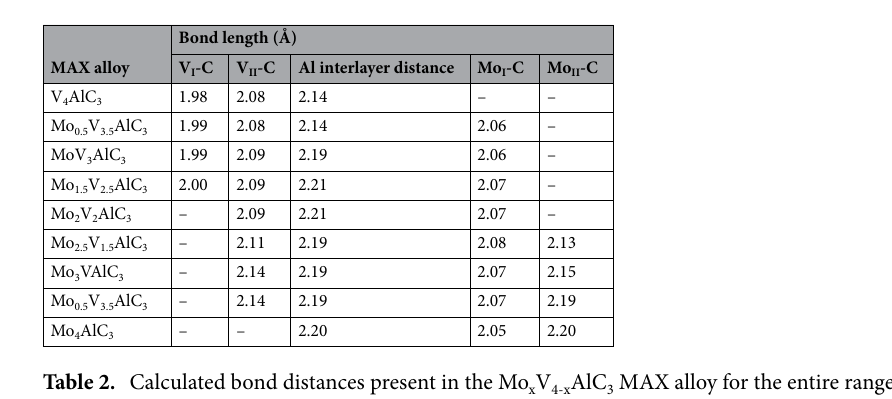
Table 2. Calculated bond distances present in the Mo x V 4-x AlC 3 MAX alloy for the entire range 0 ≤ x ≤ 4.